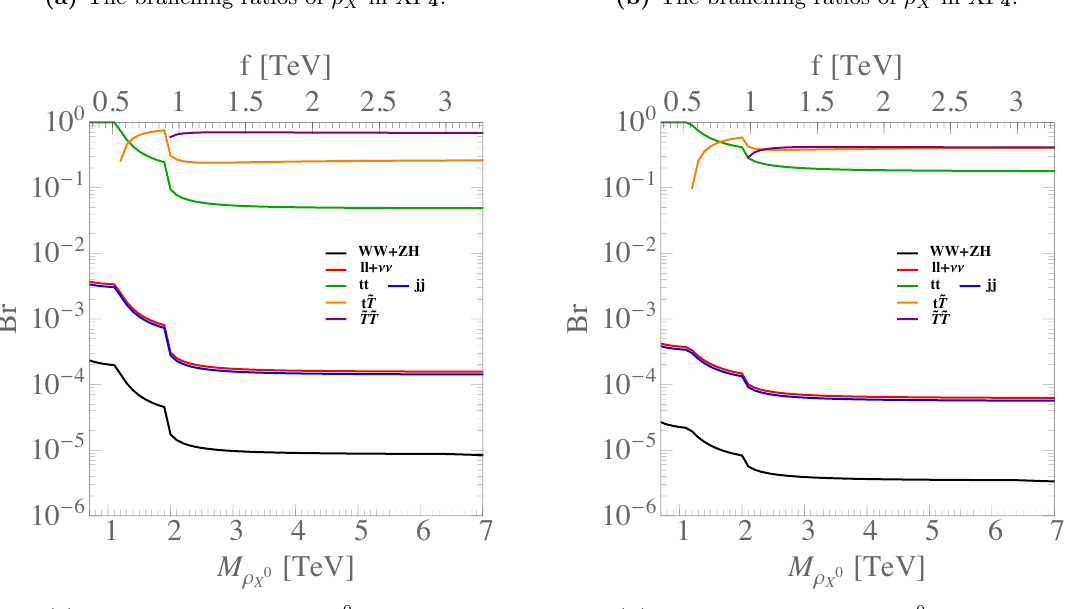
(b) The branching ratios of (cid:26) 0